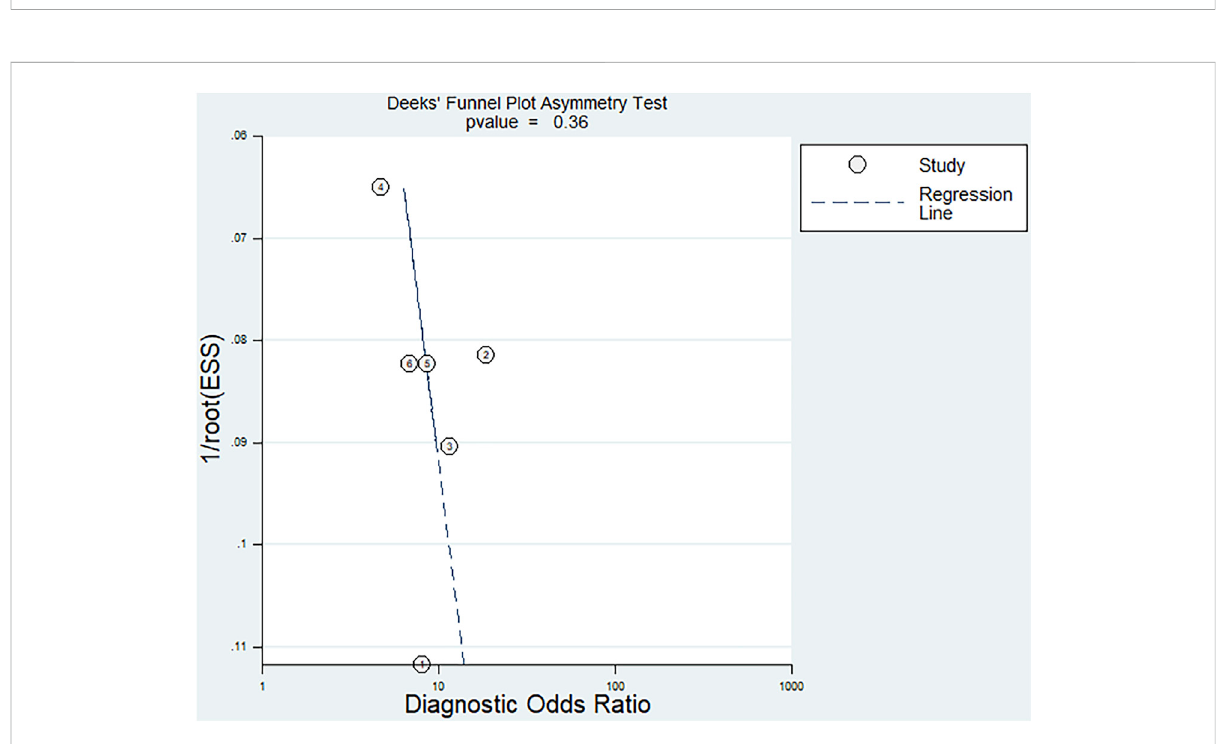
FIGURE 7 Deek ’ s funnel plot asymmetry test for assessing publication